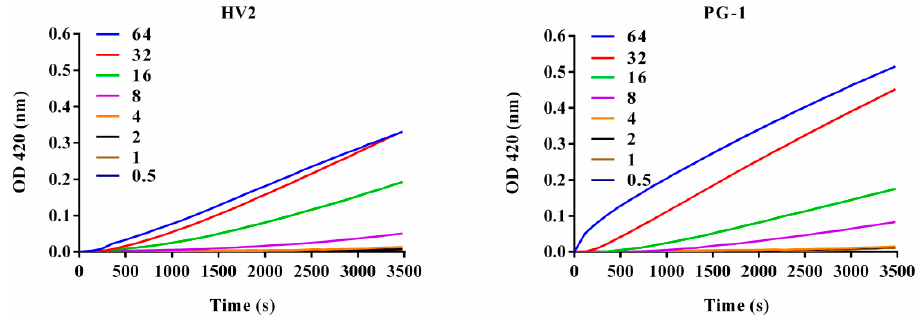
Figure 7. Inner membrane permeability of the peptides. Hydrolysis of ONPG due to release of cytoplasmic β -galactosidase of E. coli ATCC25922 treated with peptides HV2, and PG-1 at a series of different concentration (0.5 μ M, 1 μ M, 2 μ M, 4 μ M, 8 μ M, 16 μ M, 32 μ M, and 64 μ M) was measured spectroscopically at an absorbance of 420 nm as a function of time. The control was measured without the peptides .